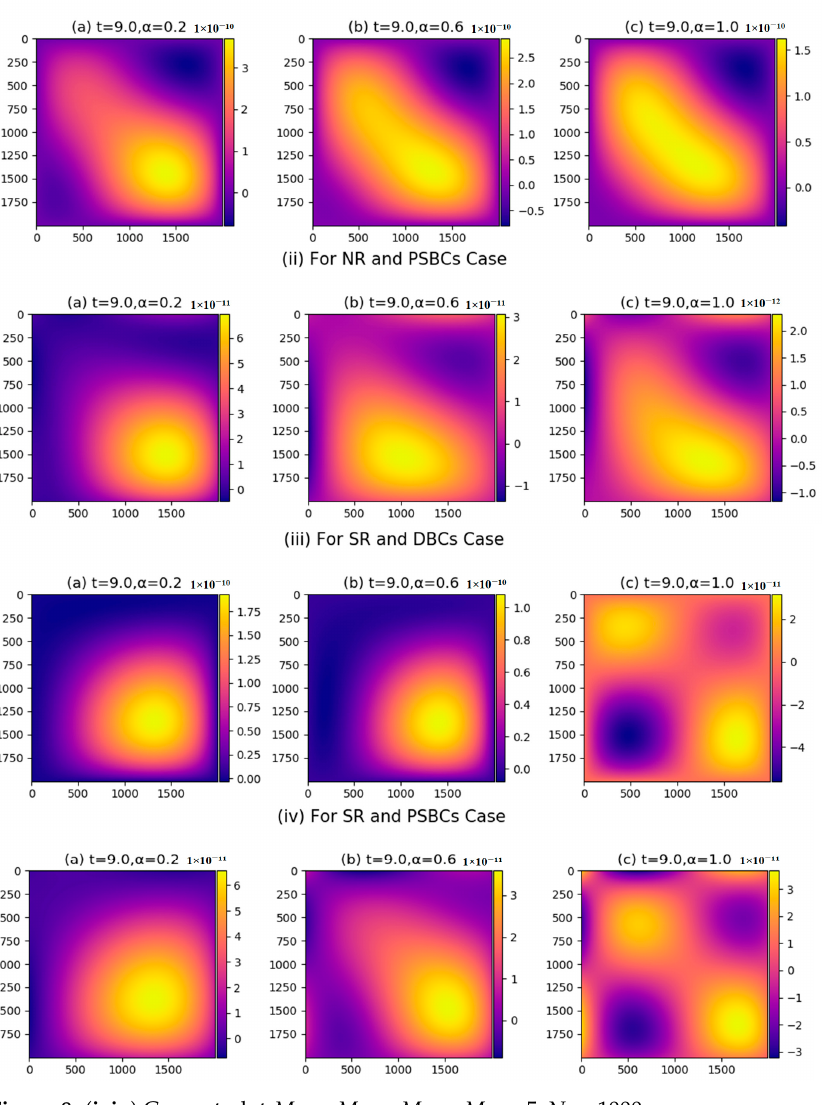
Figure 8. ( i – iv ) Current plot M 1 = M 2 = M 3 = M 4 = 5, N =